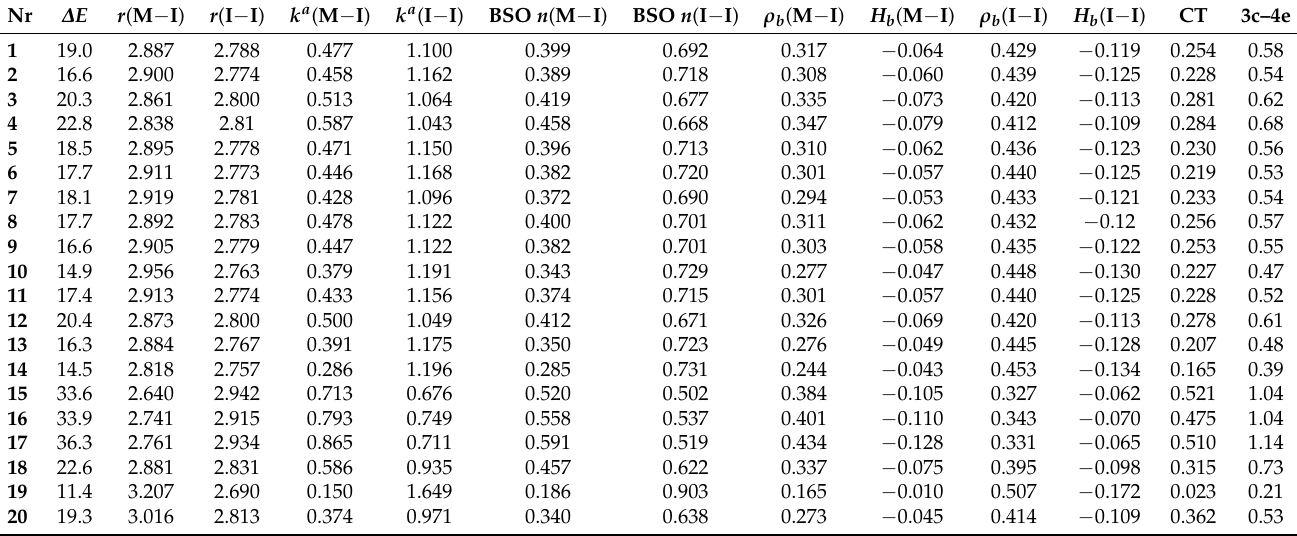
Table 1. Binding energy, bond length, local mode force constant, BSO n , electron density and energy density at bond critical point, charge transfer, and 3c–4e character for the M–I and I–I bonds of the complexes 1 – 20 a . Nr ∆